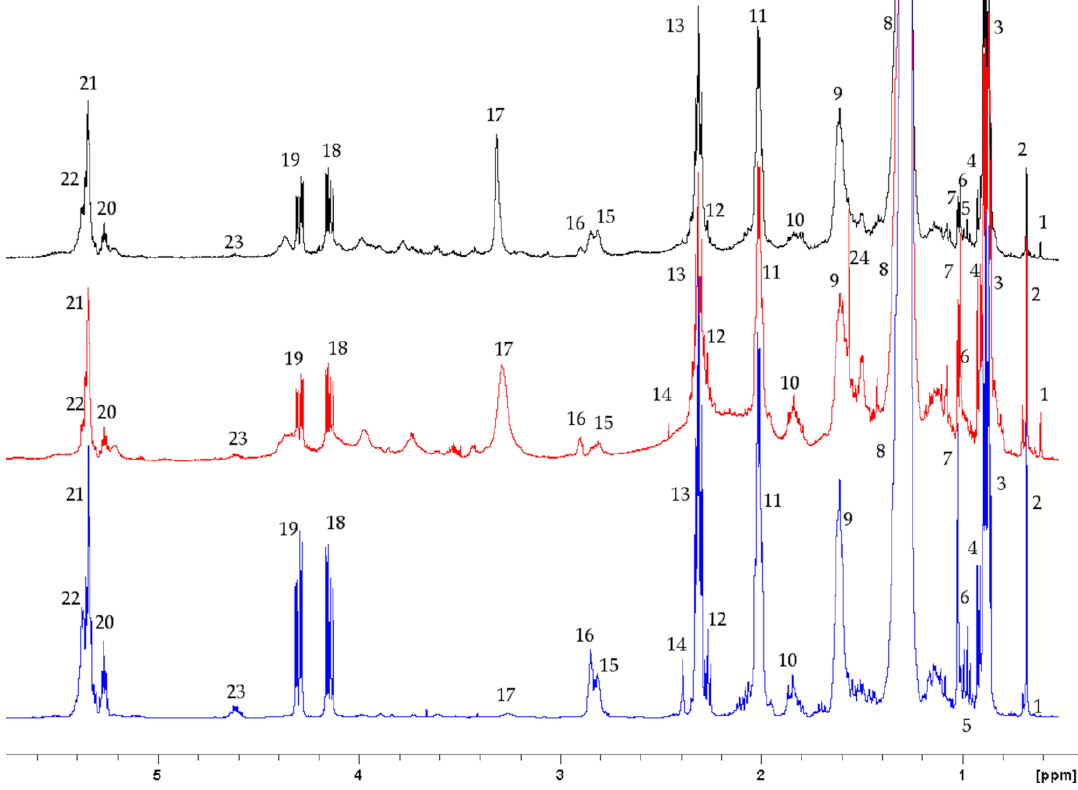
Figure 2. Representative 1 H-NMR spectra of lipophilic extracts of skeletal muscle (top/black), heart (middle/red), and liver (bottom/blue) from hatchling loggerhead sea turtles ( Caretta caretta ). The y axis is indicative of peak intensity, which correlates to concentration. Peaks 3 and 8 are truncated. Key